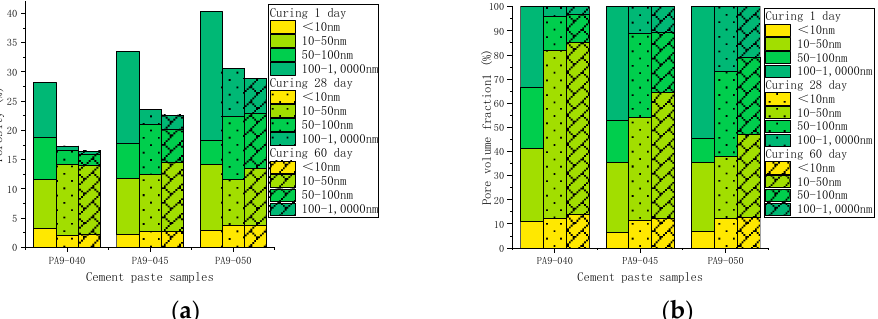
Figure 17. The pore distribution of hydrated cement pastes with different w/c: ( a ) the porosity; ( b ) the pore volume fraction.